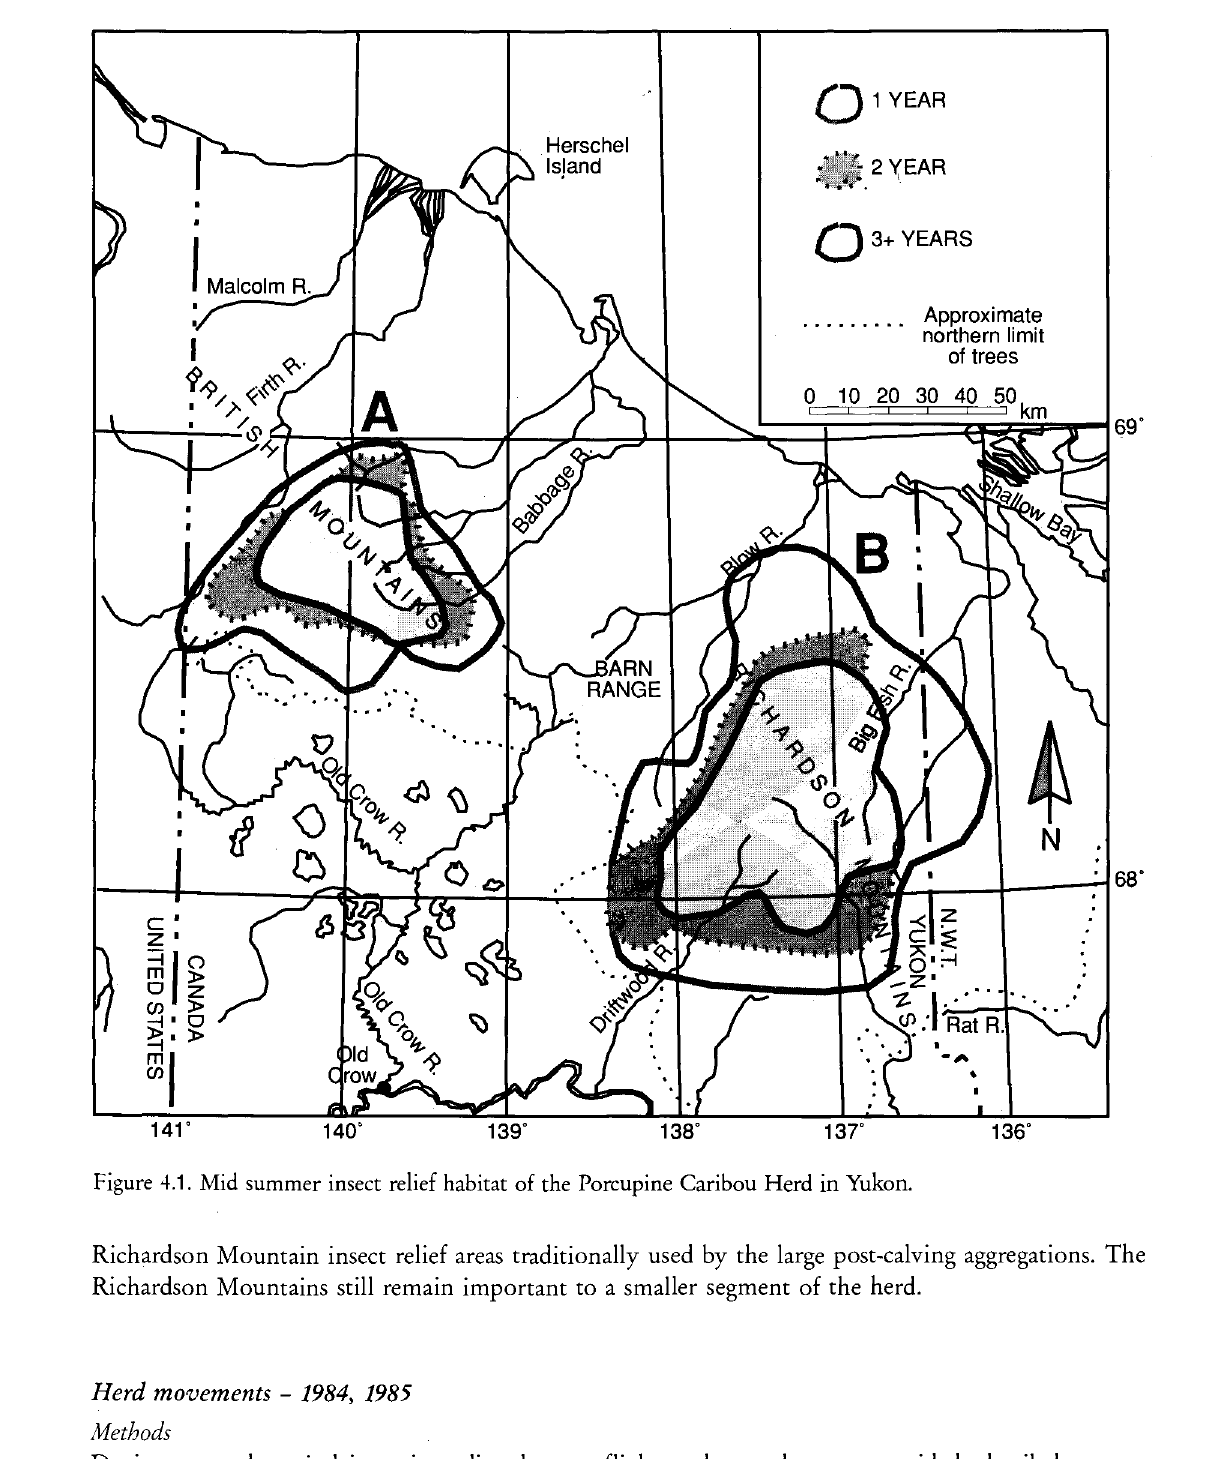
Figure 4.1. Mid summer insect relief habitat of the Porcupine Caribou Herd in Yukon. Richardson Mountain insect relief areas traditionally used by the large post-calving aggregations. The Richardson Mountains still remain important to a smaller segment of the